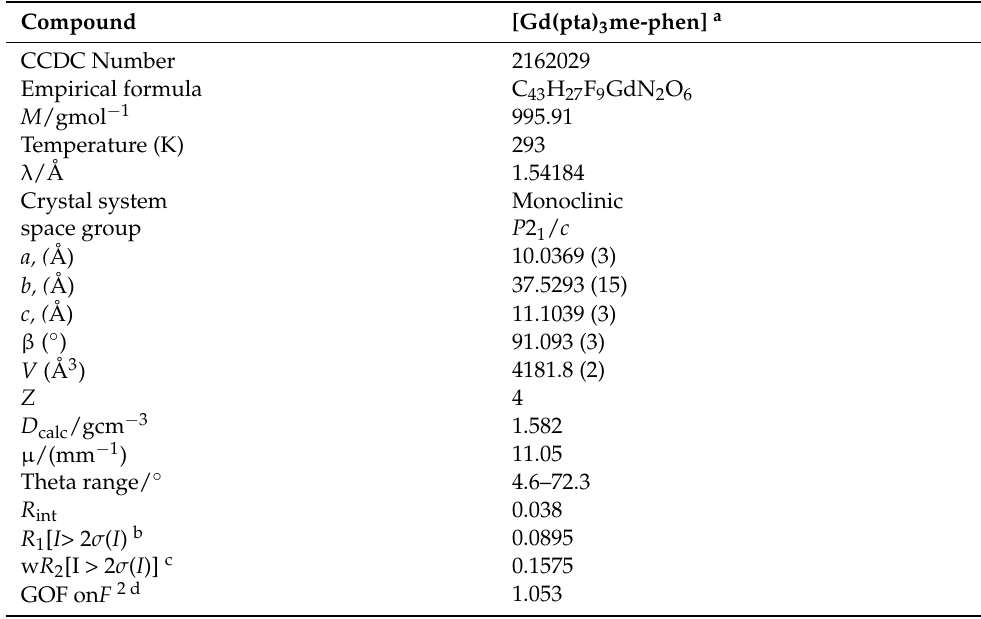
Table 1. Crystal data and structure refinement